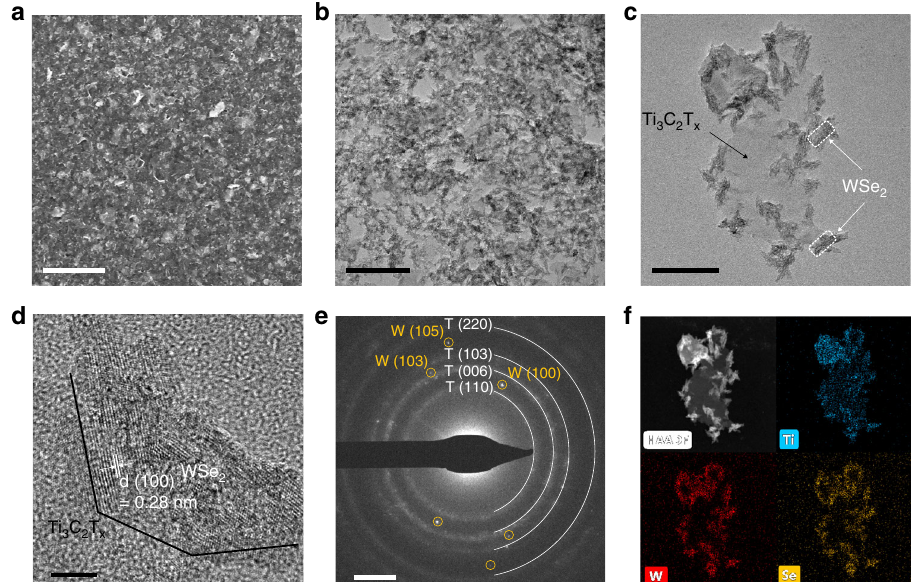
Fig. 2 Microstructure analysis of Ti 3 C 2 T x /WSe 2 nanohybrids. a SEM image of 2D Ti 3 C 2 T x /WSe 2 nanohybrid fi lm (scale bar, 2 μ m). b Low magni fi cation TEM image (scale bar, 200 nm), with c showing image of a single Ti 3 C 2 T x /WSe 2 nanohybrid (scale bar, 100 nm). d High-resolution TEM image of Ti 3 C 2 T x /WSe 2 nanohybrid (scale bar, 100 nm). e Selected area electron diffraction pattern of Ti 3 C 2 T x /WSe 2 nanohybrids (scale bar, 2 nm – 1 ). f HAADF- STEM image and corresponding elemental mapping of Ti, W, and Se for the Ti 3 C 2 T x /WSe 2 nanohybrid showing a uniform decoration of WSe 2 nano fl akes on Ti 3 C 2 T x